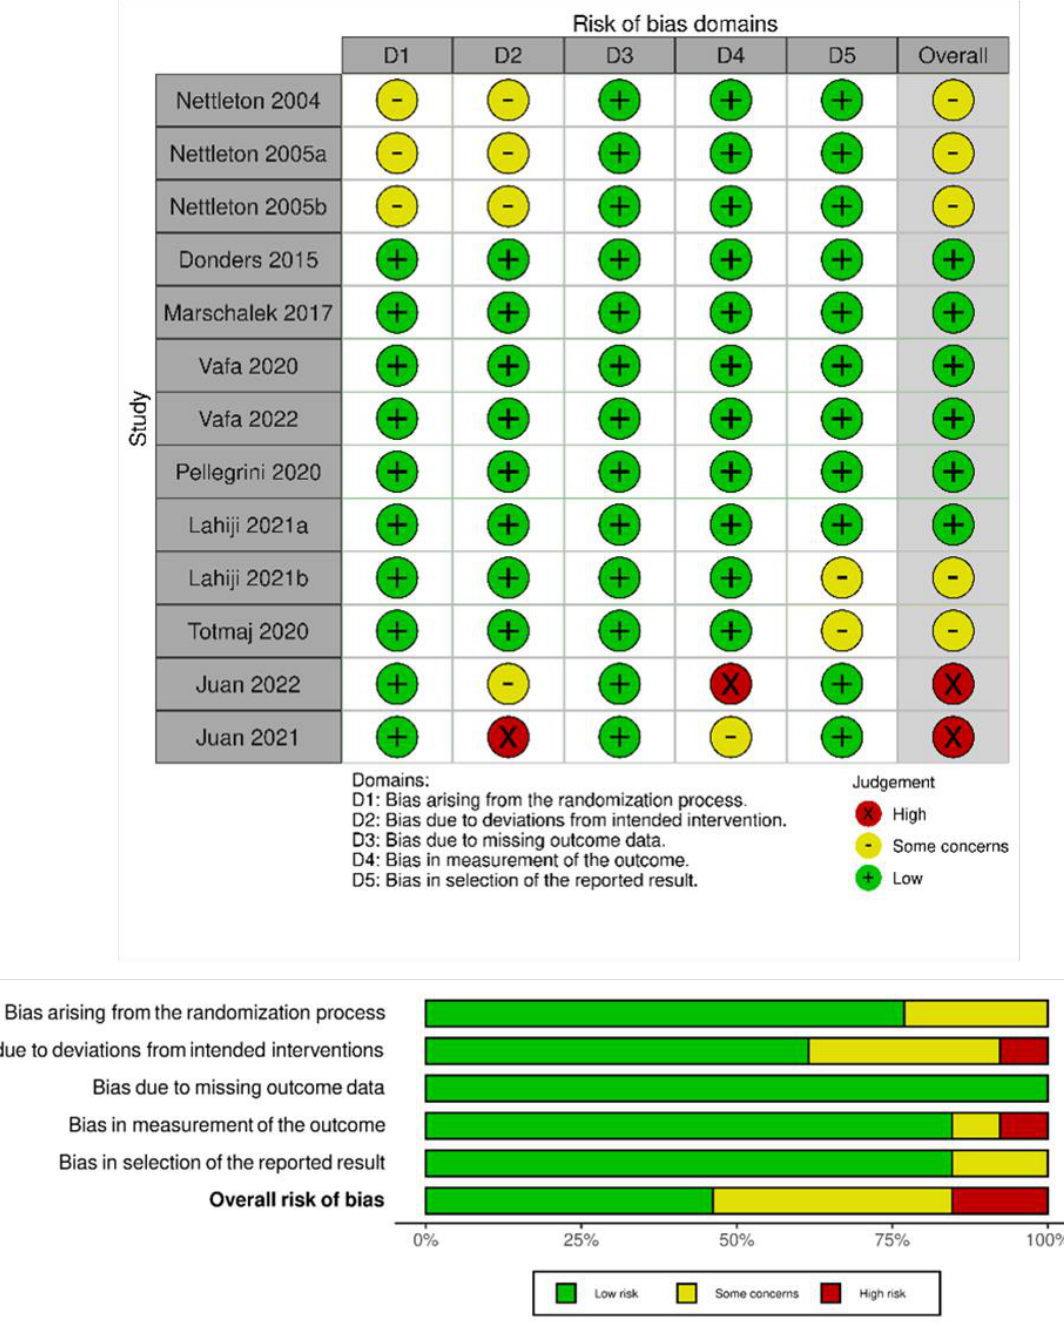
Figure 2. Risk of bias (ROB) analysis highlighting results in all domains examined within the 13 identified studies ( A ) and overall risk of bias for included studies ( B ).